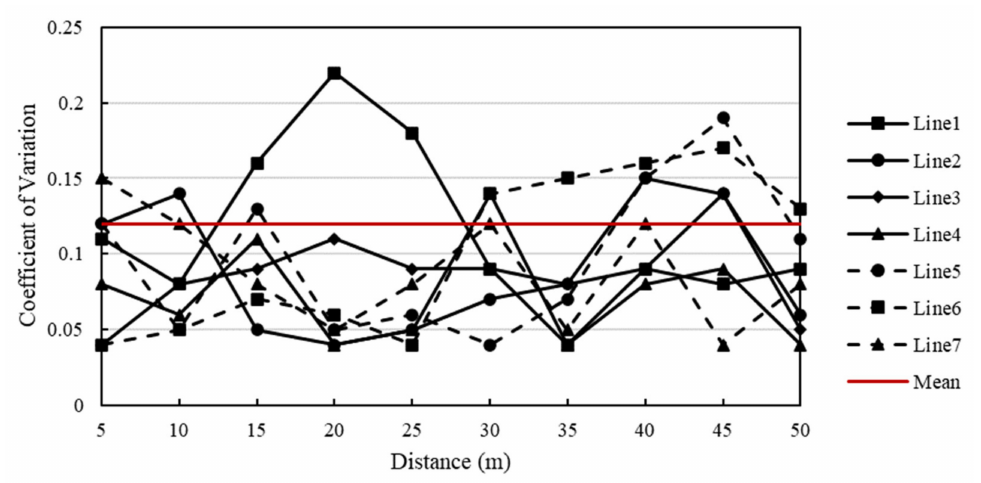
Figure 8. Thickness coefficient of variation in 70 evaluated areas.